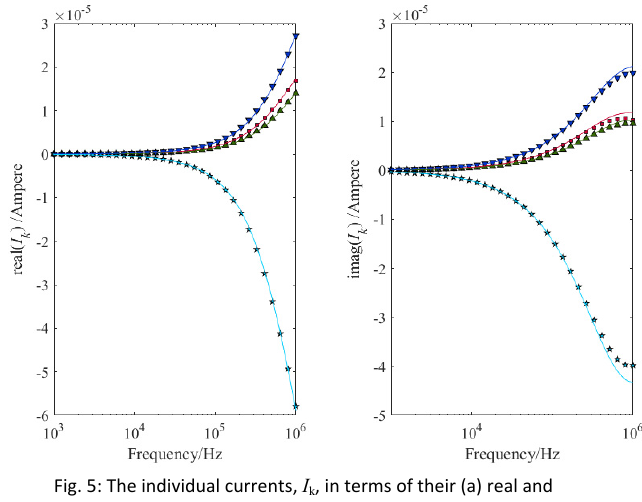
Fig. 5: The individual currents, I k , in terms of their (a) real and (b) imaginary parts for the numerical solution of the complete model (symbols) and the corresponding analytical counterpart (lines), for I 4 ( ★ ), I 2 ( ▲ ), I 1 ( ■ ) and I 3 ( ▼